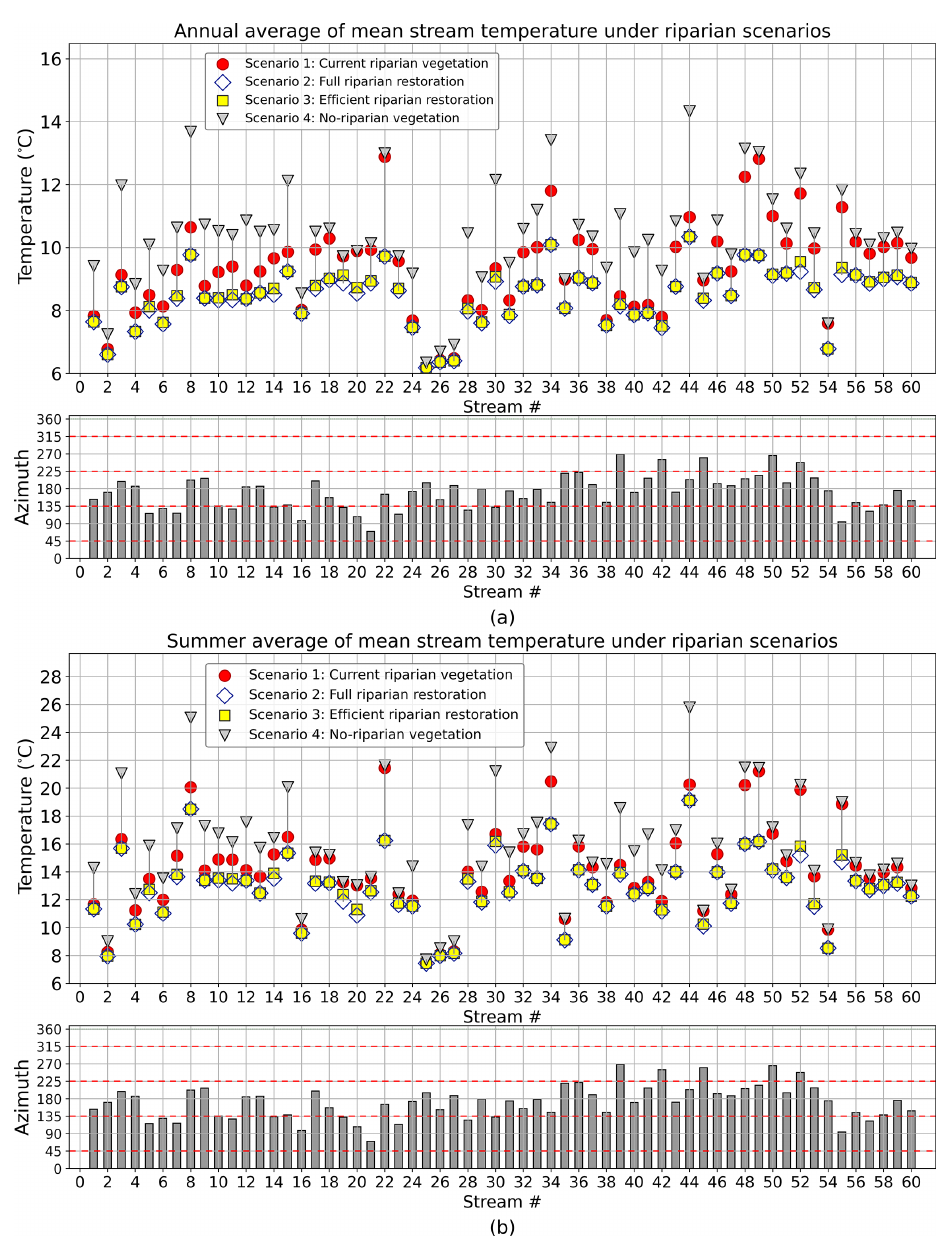
Figure 6. Result of mean stream temperature simulation for scenarios 1, 2, and 3. (a) Annual average of stream temperature. (b) Summer average of stream